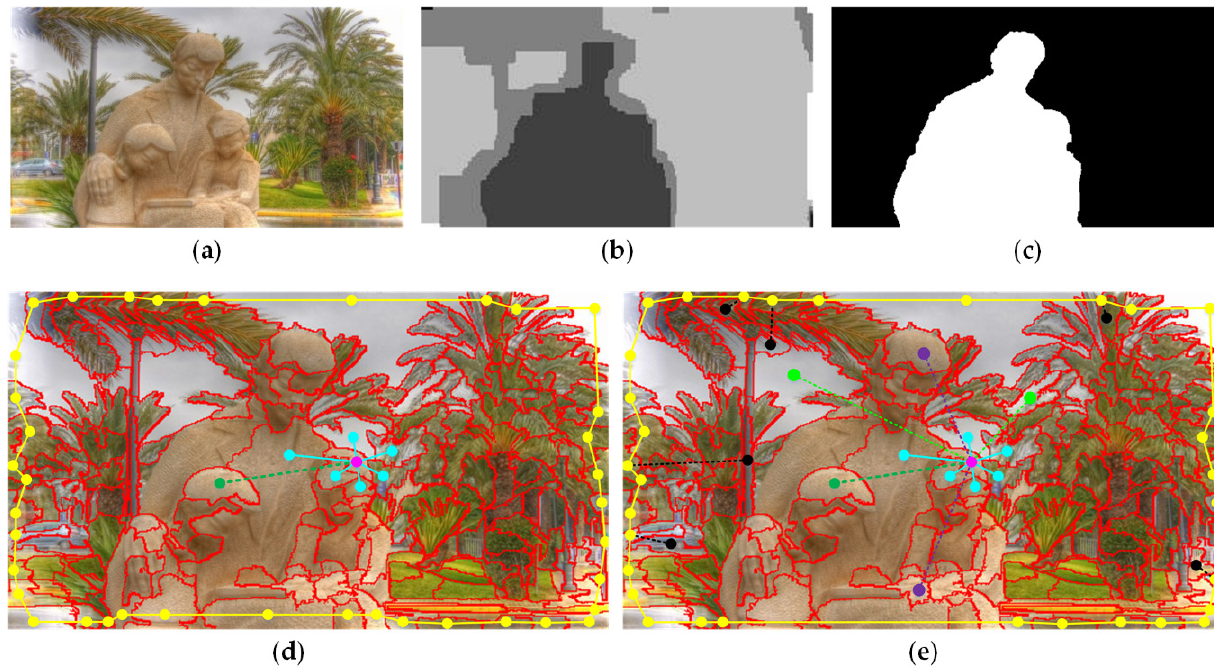
Figure 4. The construction and comparison of the proposed graph model. ( a ) Input RGB image. ( b ) Input depth image. ( c ) Ground truth. ( d ) A diagram of the connections of one of the nodes based on initial two-layer sparse graph. A node (illustrated by a pink dot) connects to its adjacent nodes (blue dots and connections) and the most similar node (dark green dots and connections) sharing common boundaries with its adjacent nodes. All edge nodes are connected to pairs (yellow dots and local connections). ( e ) A diagram of the connections of one of the nodes based on improved two-layer sparse graph. Different from the initial graph, the new edge nodes first remove some foreground nodes which are in the image boundary (the nodes at the bottom edge of image), and further join a small number of non-edge background nodes (black nodes). Each pair of the new edge nodes connects to each other (yellow and black dots and connections). Additionally, each node connects to the background seeds (light green dots and connections) and the foreground seeds (purple dots and connections).